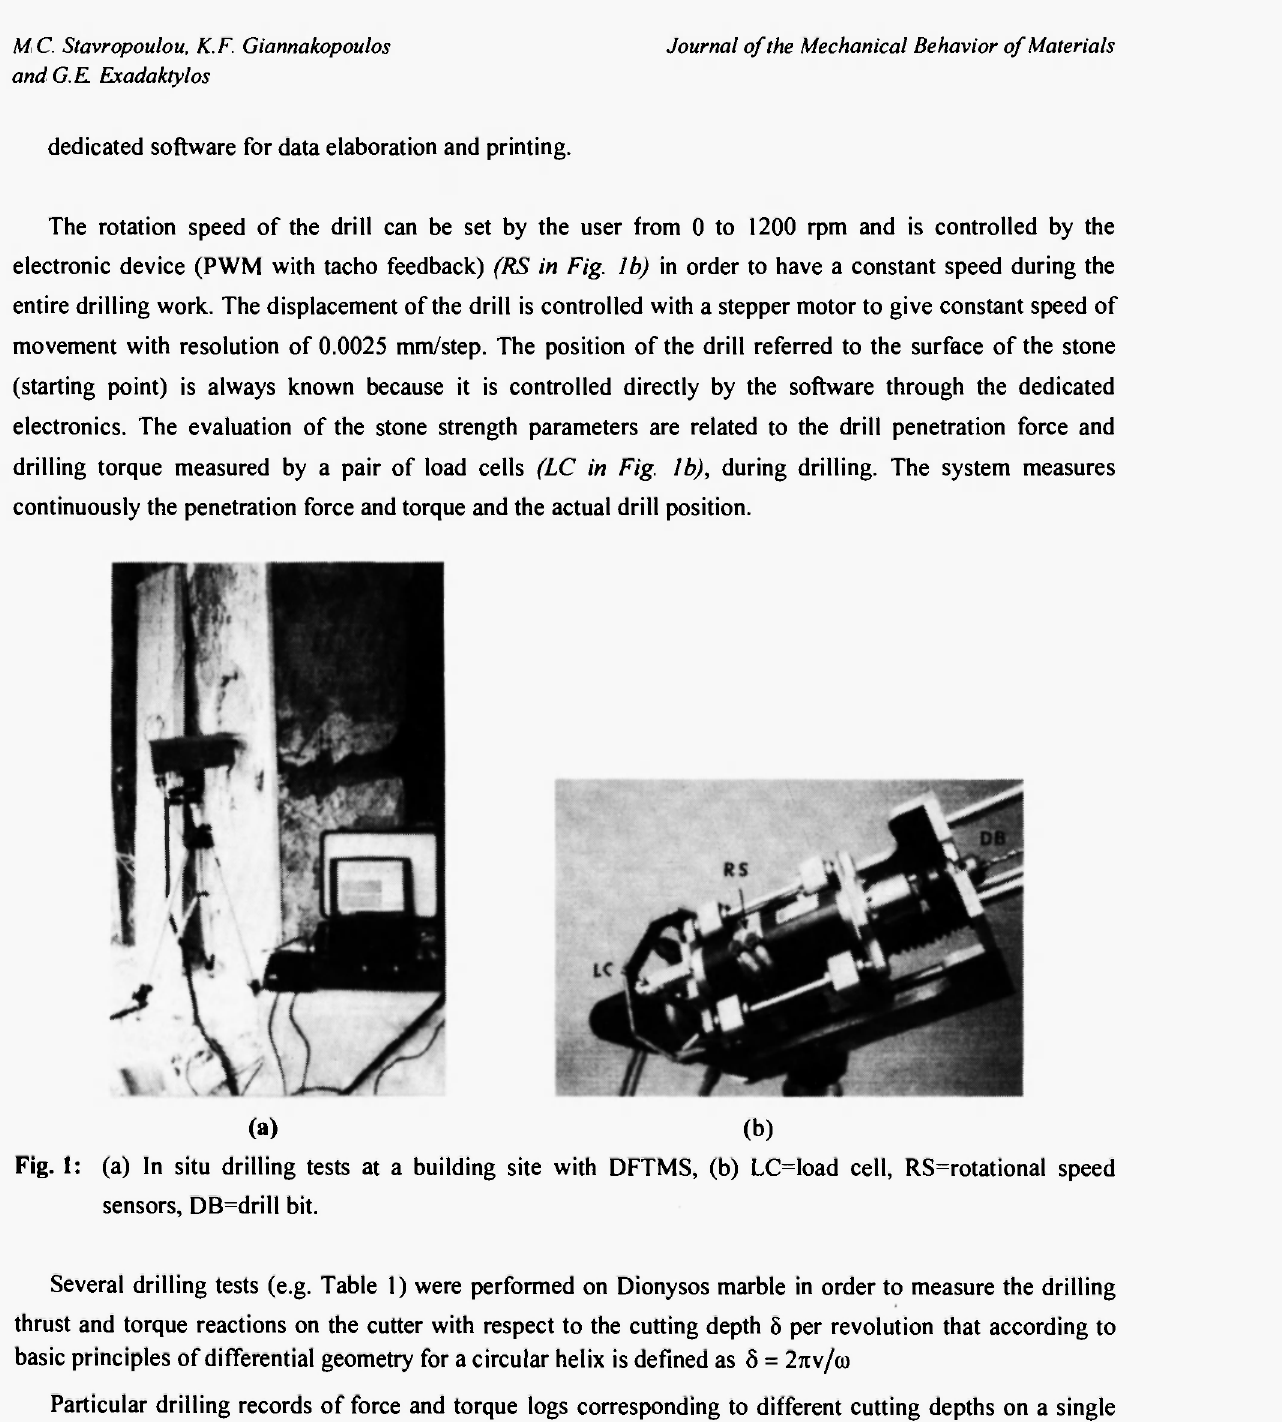
Fig. 1: (a) In situ drilling tests at a building site with DFTMS, (b) LC=Ioad cell, RS=rotational speed sensors, DB=drill